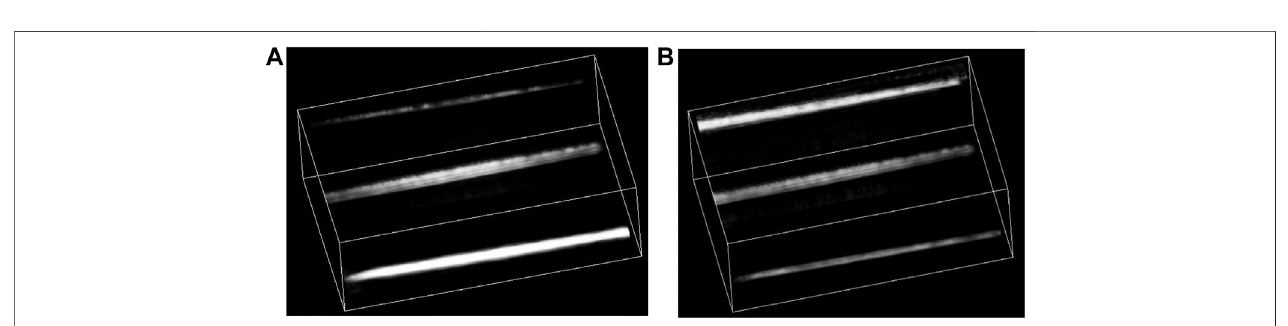
FIGURE 8 | (A) 3D result of three carbon rods without fl uence compensation; (B) 3D result of three carbon fi bers with fl uence